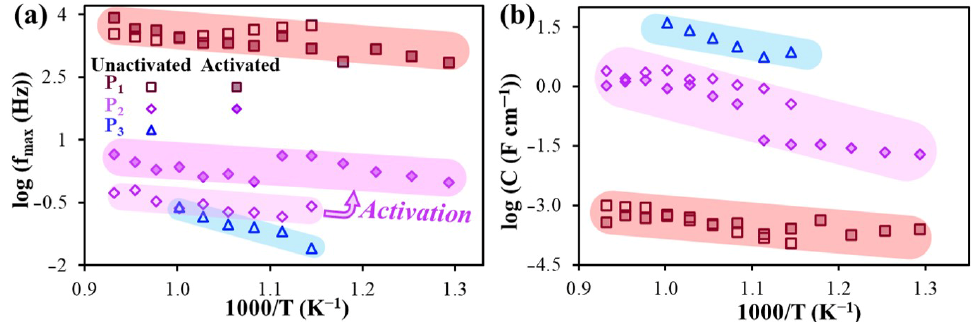
Figure 7. Frequencies ( a ) and capacitances ( b ) determined by fitting impedance spectra correspond-